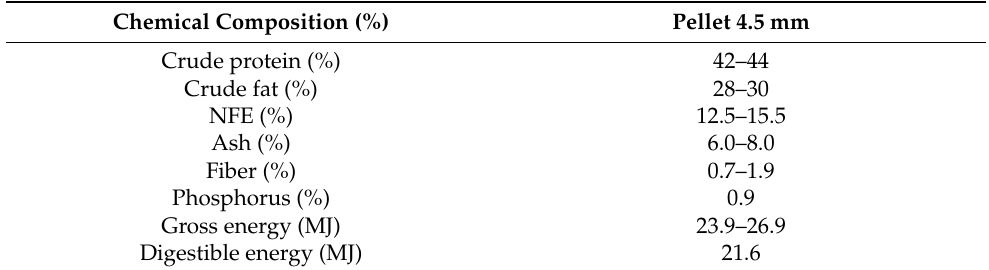
Table 1. Chemical composition of feed administered in farms, according to the product label